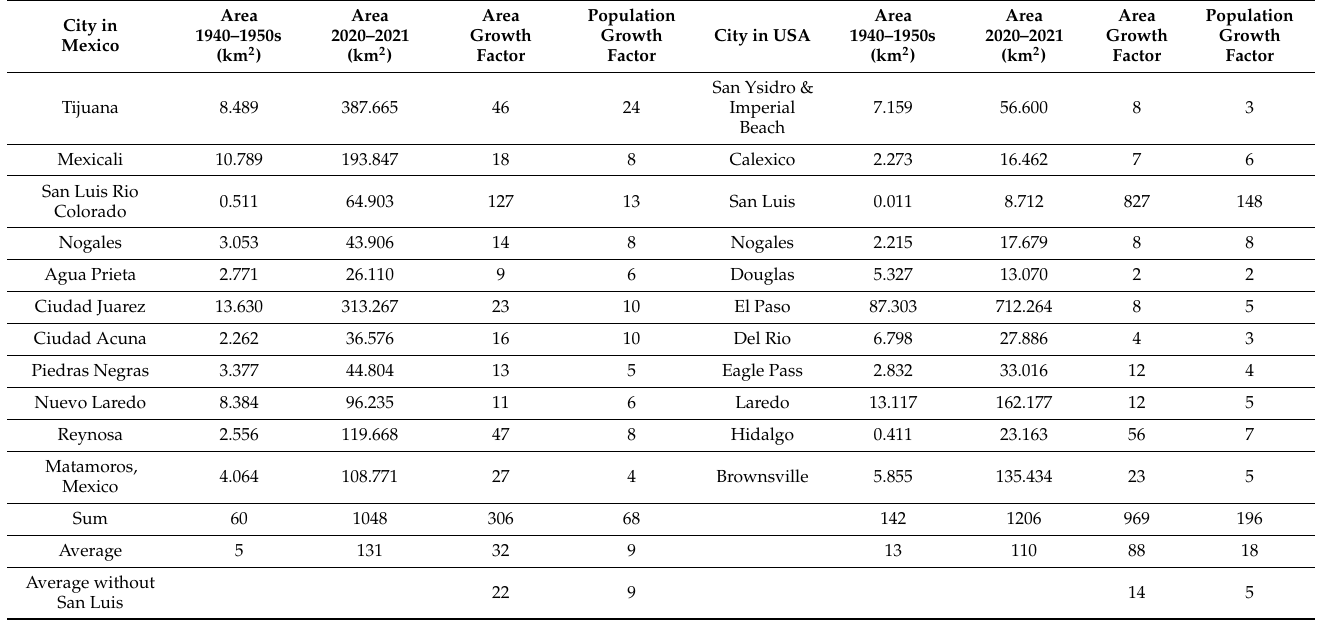
Table 4. Area sizes and growth as calculated from the aerial and satellite